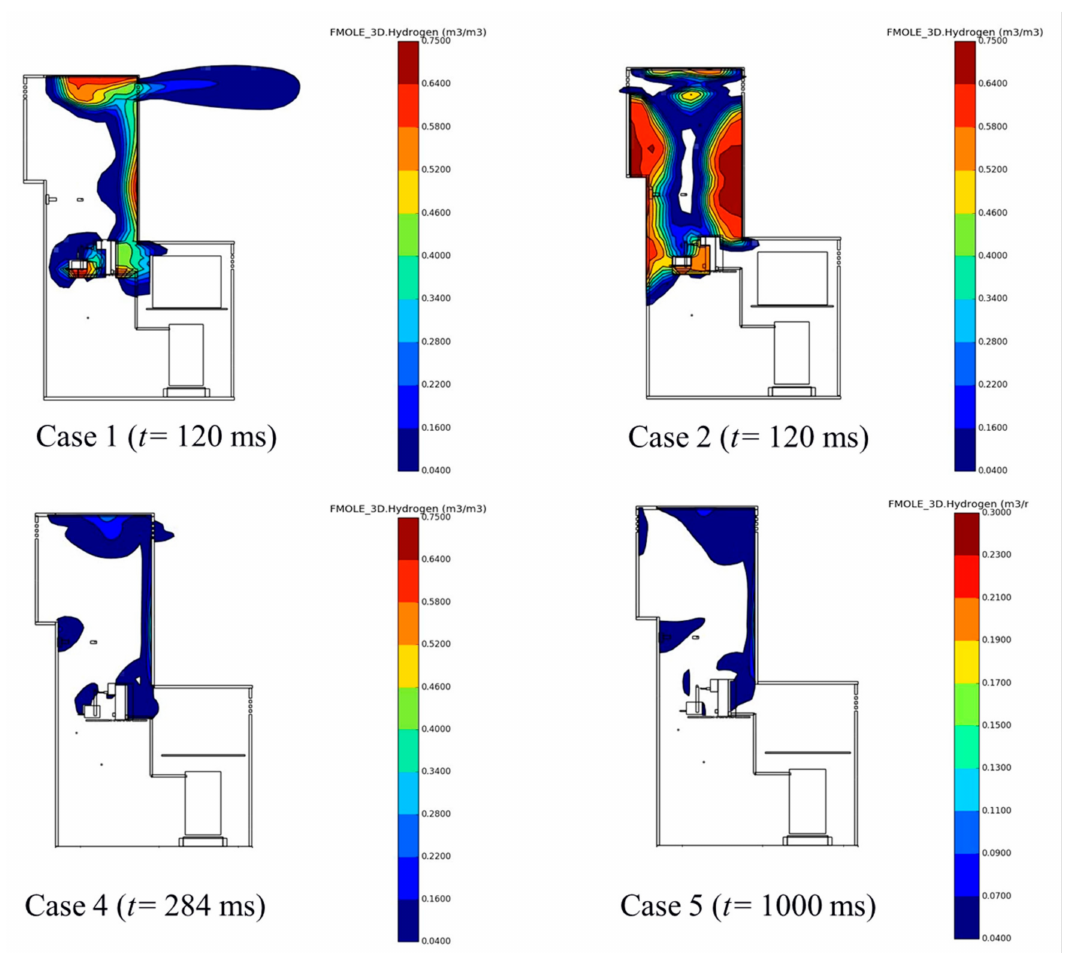
Figure 6. Comparison of the time that hydrogen reaches the top of the dispenser. Consequently, the hydrogen distribution after the leakage is stopped can be investi- gated. Figure 7 shows the volume fraction on the section in the middle of the dispenser for Case 3, 4, and 5 to show the situation after stopping the leakage, and that of Case 1 is given as a contrast. By comparing the result from Case 1 and Case 3, it is evident that the ignitable clouds outside the dispenser will dissipate in a short time once the leakage is stopped. The same conclusion can be addressed for small scale leakage in Case 4 and Case 5. Hence, attention should be paid to the hydrogen left inside. Due to the slow diffusion, it seems that to design the dispenser with more vent holes with larger sizes may not be effective in case the leakage is not stopped in a timely manner. Further investigations are still required to draw the conclusion though, since the wind effect is not considered in the above